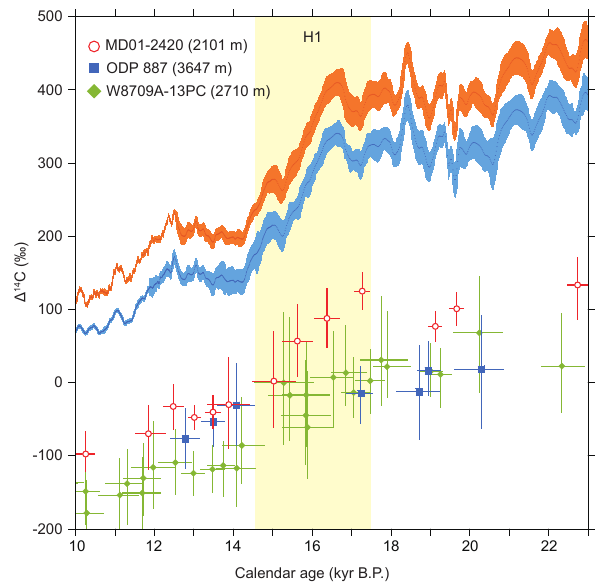
Fig. 5. 1 14 C change in core MD01-2420 (this study), core ODP Fig. 5. Okazaki et al. 887 in the Gulf of Alaska (3647m, Galbraith et al., 2007) and core W8709A-13PC in the eastern North Pacific (2710m, Mix et al., 1999; Lund et al., 2011) between 10 and 23kyr BP along with Int- cal09 and Marine09 curves (Reimer et al.,